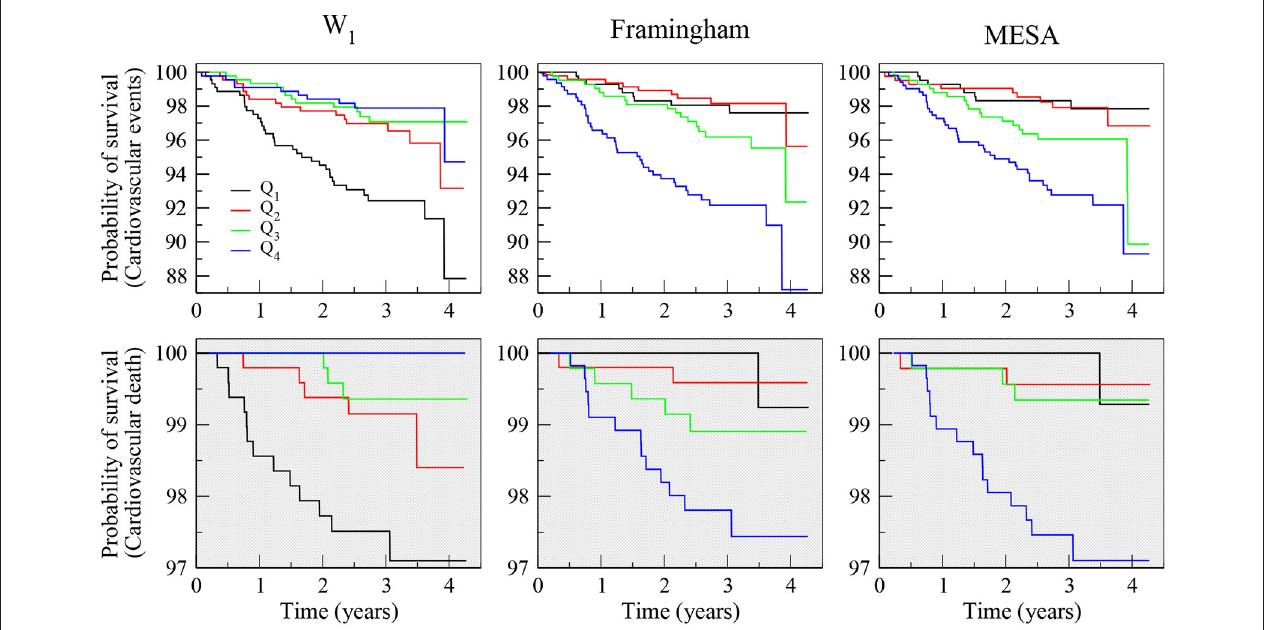
FIGURE 3 | Kaplan-Meier survival curves of analyses of incident CVEs (top panels) and CV mortality (bottom panels), showing the percentage of symbolic words with one inflection point (W 1 ) derived from RR interval time series (left panels), the Framingham (middle panels) and MESA (right panels) CV risk indices. Q 1 –Q 4 indicate first to fourth quartiles. Note that participants in the highest quartile of the Framingham and MESA risk indices had the worst prognosis and those in the highest quartile of word class W 1 (more fluent, less fragmented) had the best prognosis.